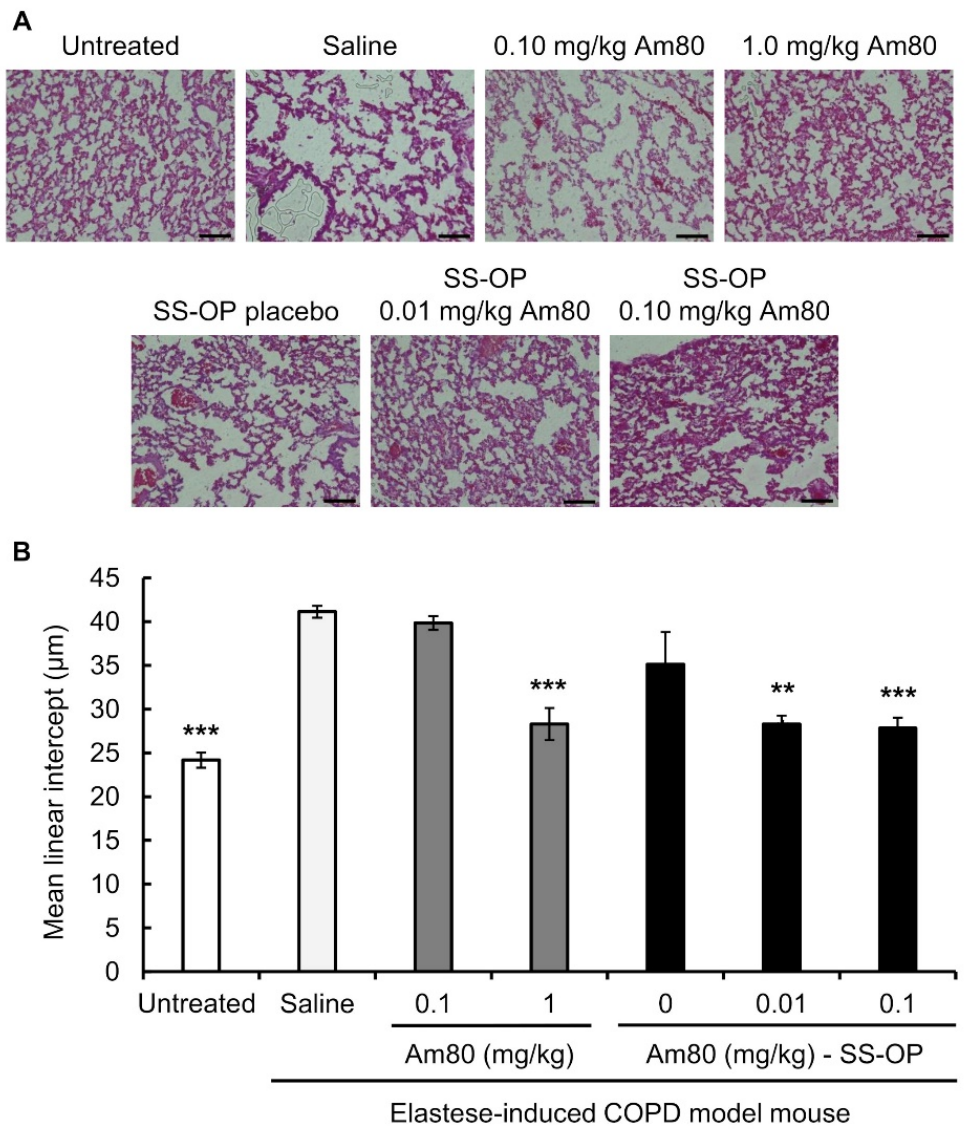
Figure 3. Effect of free Am80 or Am80-encapsulated SS-OP nanoparticles on Lm in the elastase- induced COPD model mouse. ( A ) A lung section observed under a BZ-9000 microscope ( × 20. Scale bar: 100 µ m). ( B ) The mean linear intercept (Lm). Sections were stained with H&E. Data represent the mean ± S.E. (n = 5–8). ** p < 0.01 and *** p < 0.001, Dunnett’s test, vs. saline group.